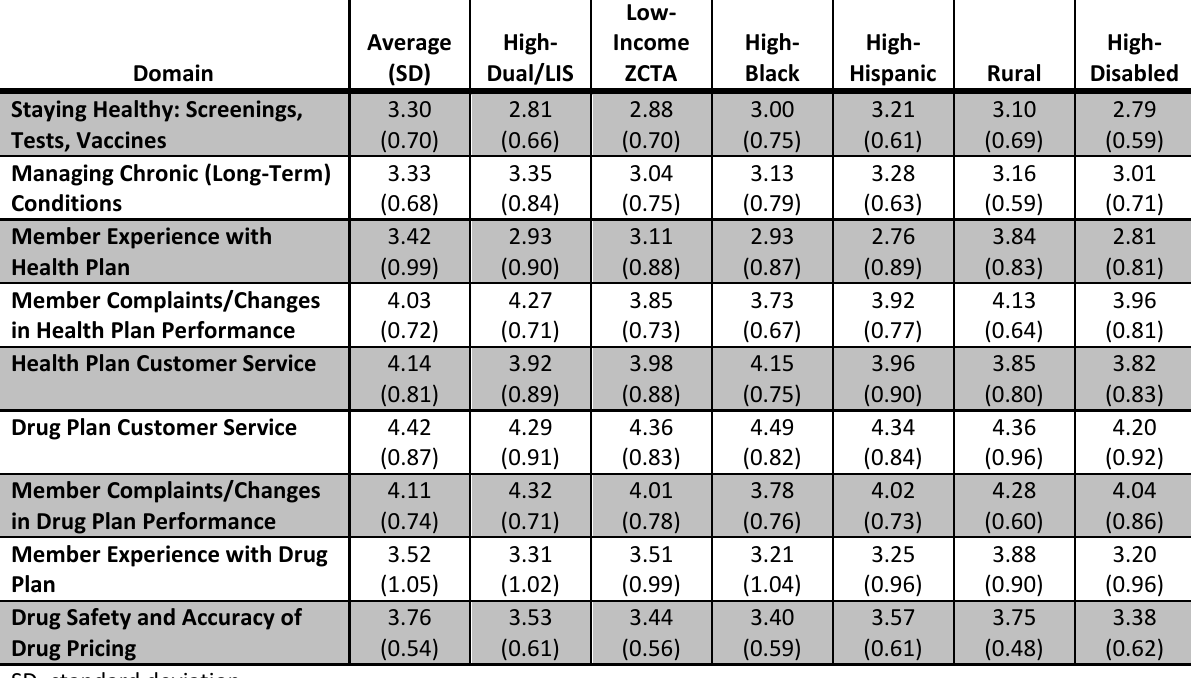
Table 8.6: Contract Social Risk and Domain